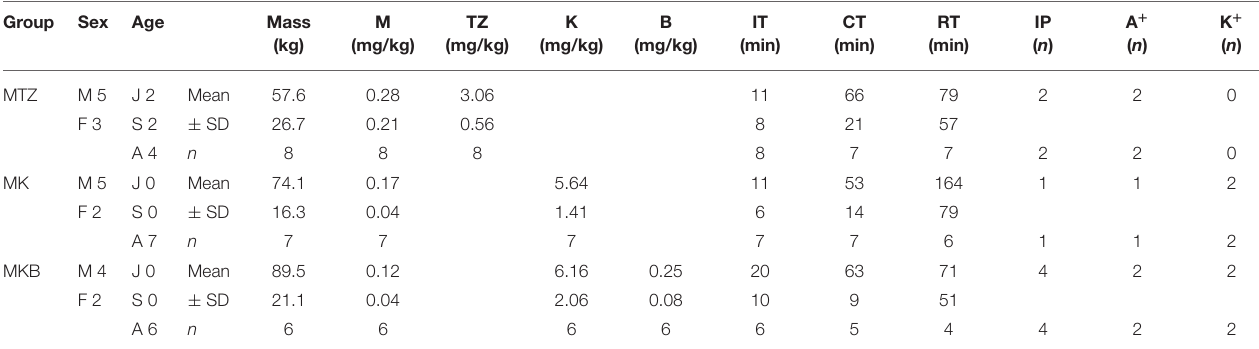
TABLE 1 | Drug doses and capture time course data of cage-trapped wild boars anesthetized using medetomidine-tiletamine-zolazepam (MTZ; n = 8) or medetomidine-ketamine (MK; n = 7) or medetomidine-ketamine-butorphanol (MKB; n = 6). Group Sex Age Mass M (kg)